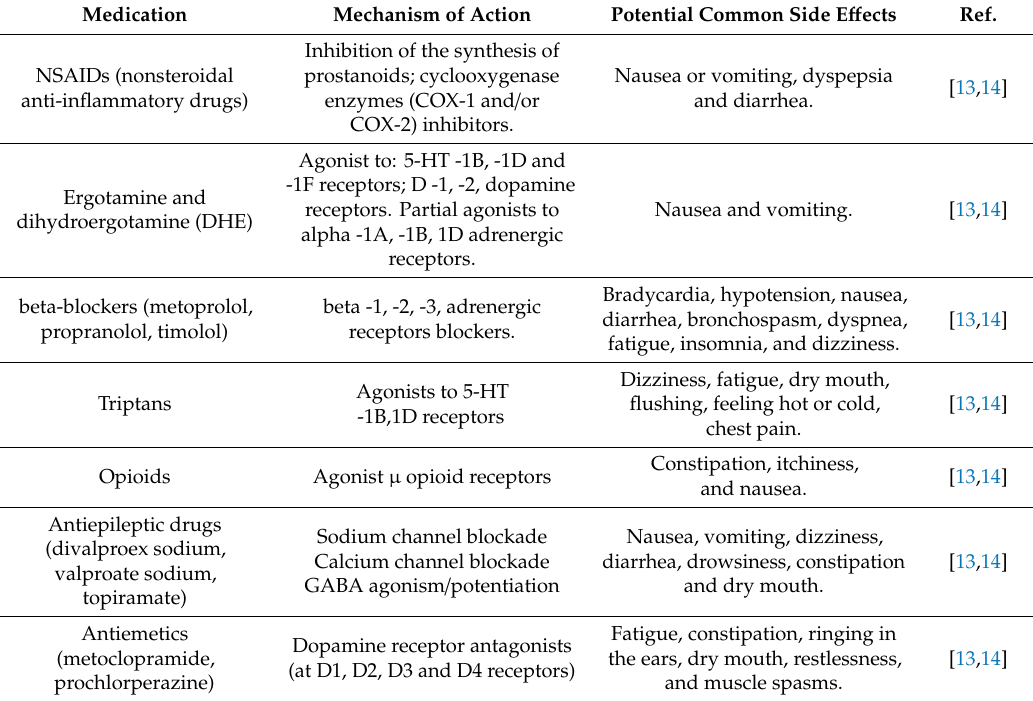
Table 1. Current pharmacological treatment in